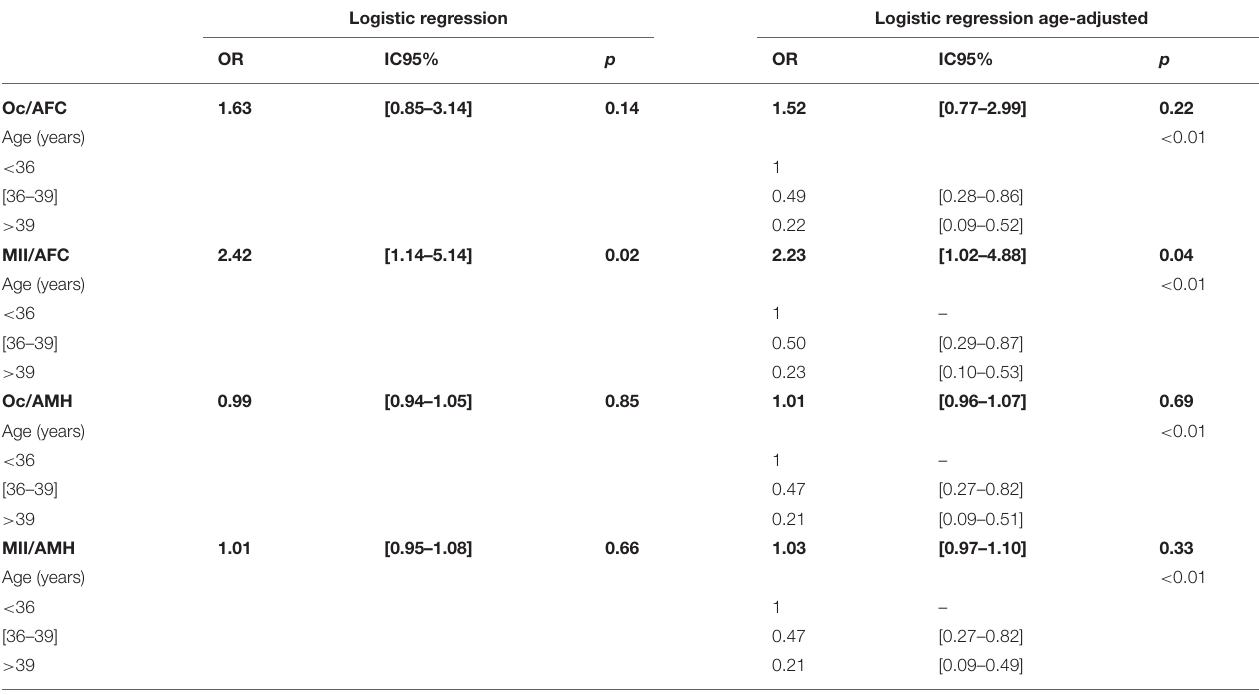
TABLE 4 | Odds ratios of oocyte yield indices after cumulative embryo transfer according to age groups. Logistic regression Logistic regression